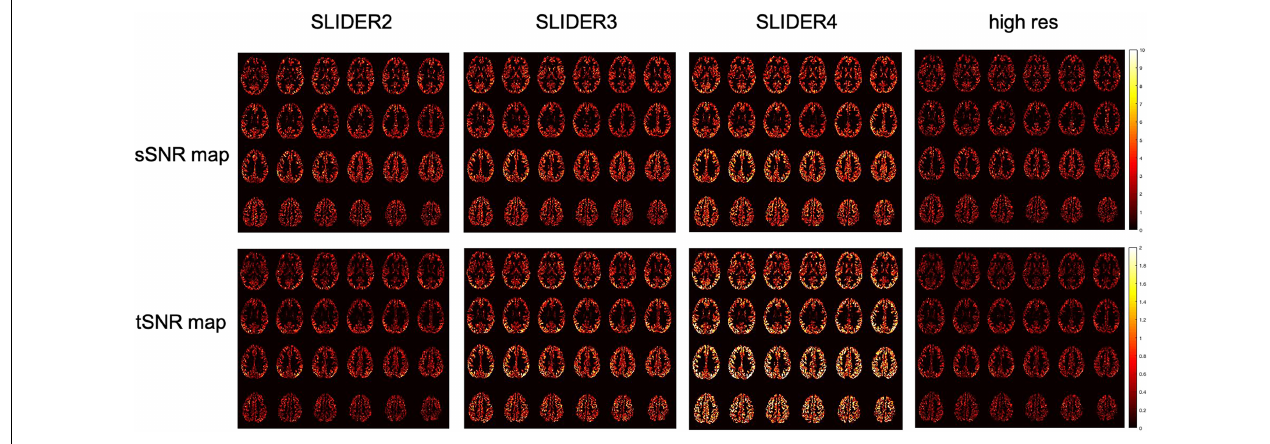
Frontiers in Neuroscience |